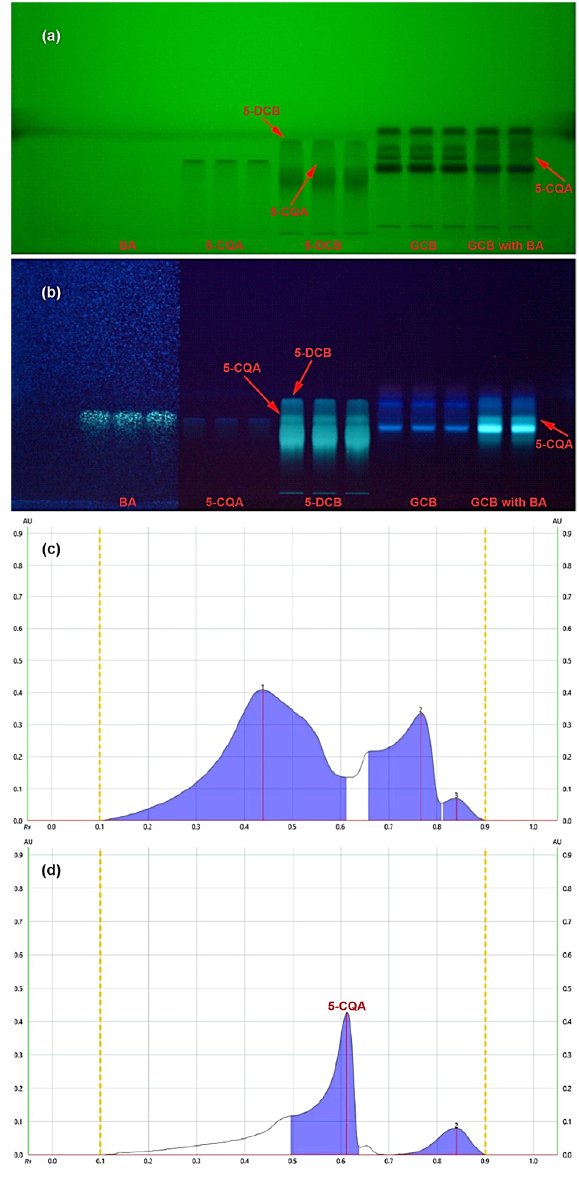
Figure 1. HPTLC/UV densitometry: ( a ) HPTLC chromatogram at 254 nm; ( b ) HPTLC chromatogram at 365 nm; ( c ) UV densitogram for 5-DCB complex (peak 2) at 280 nm; ( d ) UV densitogram for 5-CQA at 280 nm. BA: Boric acid; 5-CQA: 5-Caffeoylquinic acid; 5-DCB: Diester chlorogenoborate; GCB: Green coffee bean; HPTLC: High-performance thin-layer chromatography; UV: Ultraviolet.